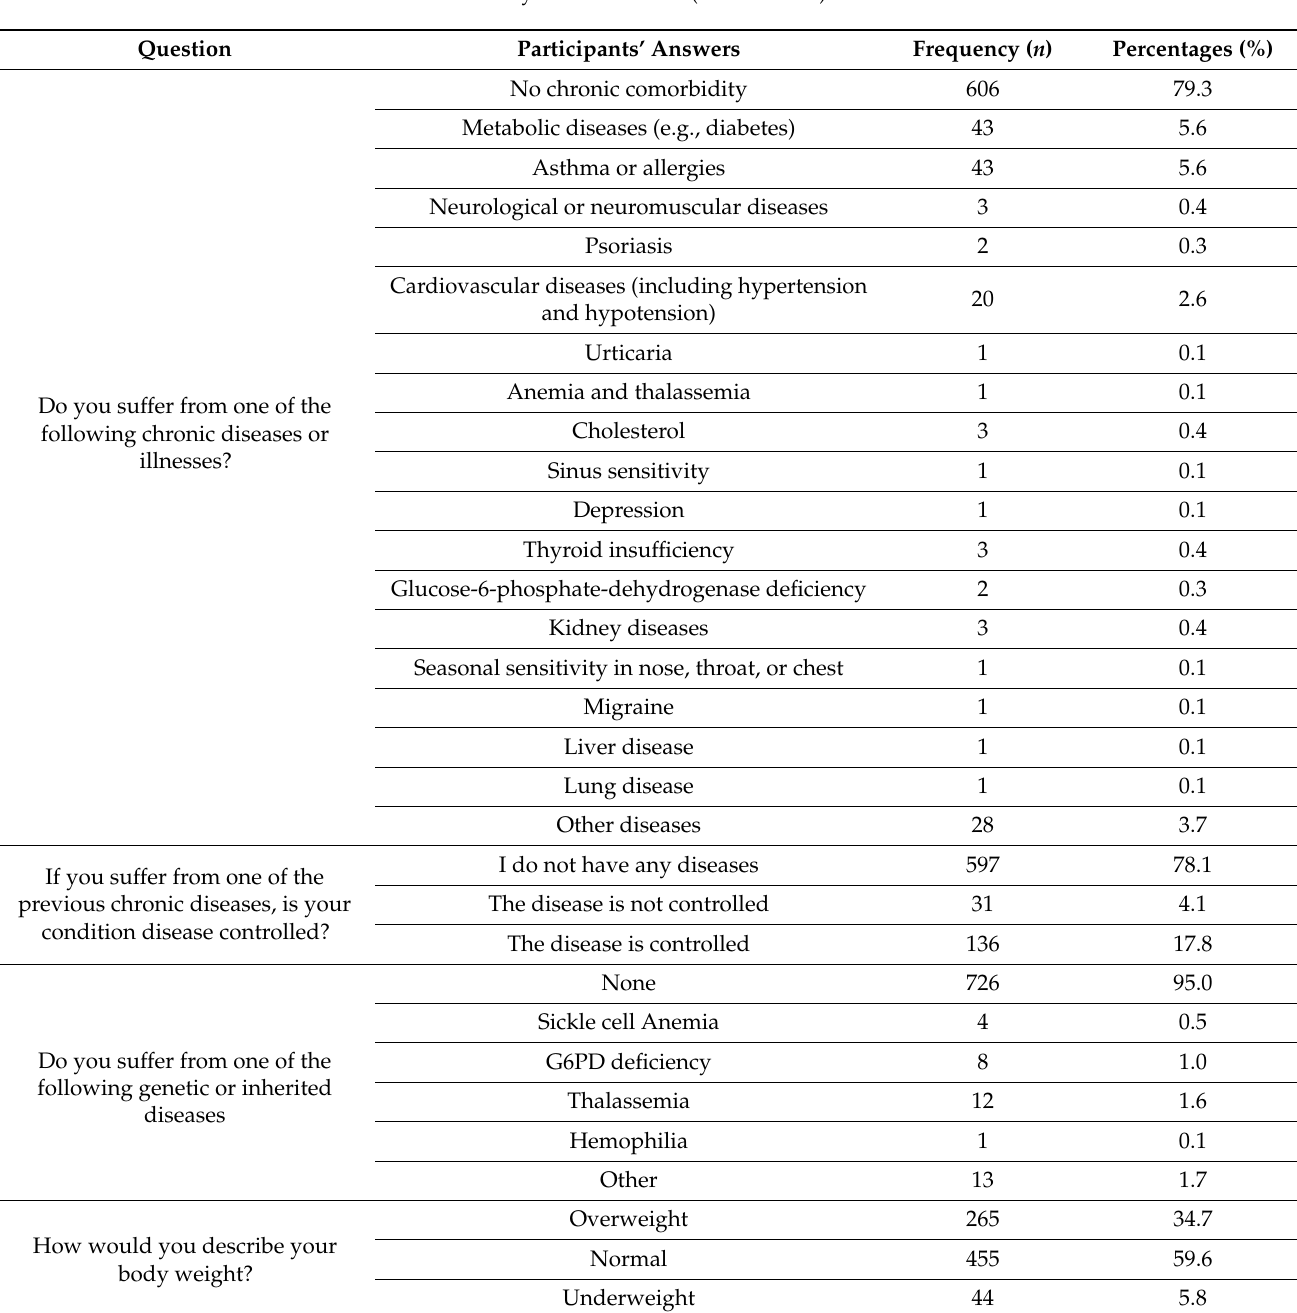
Table 2. Number and percentages of questions including factors that may be influencing the efficacy and short-term safety of the vaccines (total n =